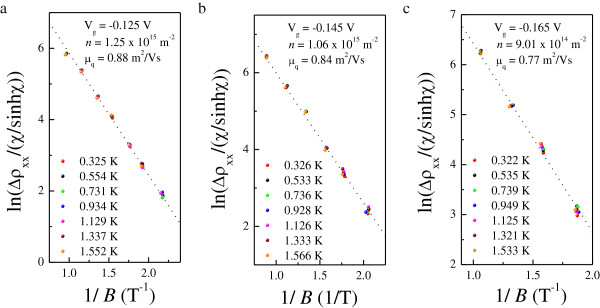
ln (Δρxx(B,T)/D(B,T)) as a function of 1/B. For (a)Vg = −0.125 V, (b)Vg = −0.145 V, and (c)Vg = −0.165 V. The dotted lines are the fits to Equation 1.